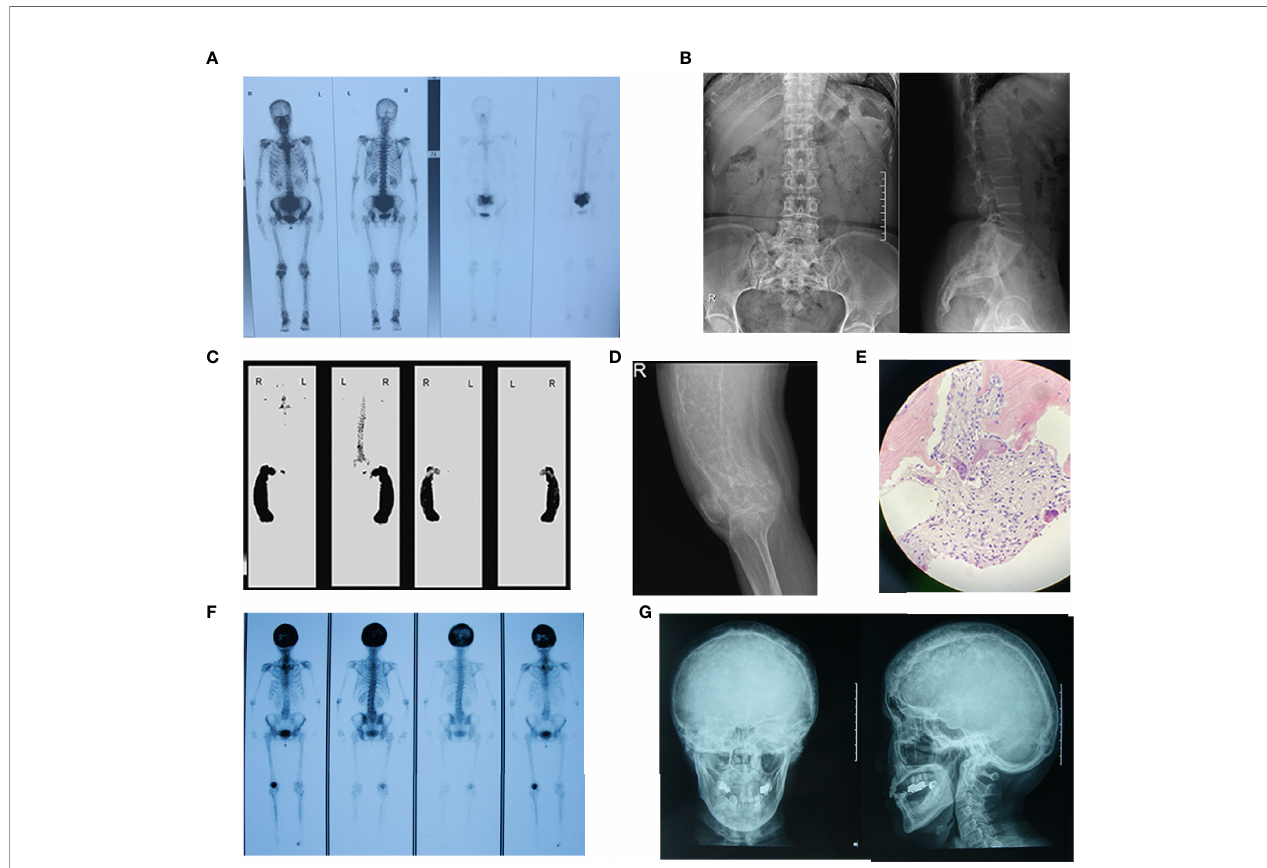
FIGURE 2 | Bone scintigraphy and X-ray images of patients with PDB. (A) Bone scintigraphy image depicted with high 99 m Tc-MDP uptake in sacral vertebrae. (B) The frontal and lateral pelvic radiograph showed heterogeneous sclerosis density involving sacral vertebrae. (C) The bone scan showed enlargement and bending in a “ knife arc ” pattern of the left femur, accompanied by high 99 m Tc-MDP uptake in the left femur. (D) The radiograph of the left femur revealed structural changes with signi fi cant bowing, cortical destruction and dilation. The trabecular bones were coarse and arrayed irregularly, showing a “ towel gourd sac-like ” appearance and loss of the normally clear distinction between the cancellous bone and cortical bone. (E) Biopsy of the left femoral mass revealed osteoclastic giant cells and bone resorption with fi brous tissue hyperplasia. Patient 12 F Bone scintigraphy image depicted with high 99 m Tc-MDP uptake in the skull. (G) The plain skull fi lm showed craniocerebral thickening with the skull plate barrier disappearing. The cranial suture could not be clearly displayed with the mixture of high-density and low-density areas, and the sclerotic foci showed a dense cotton spherical